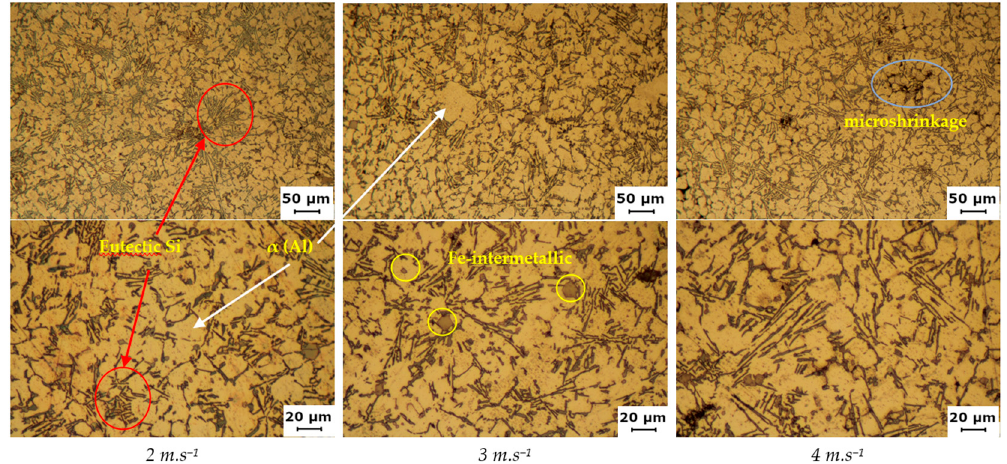
Figure 9. Micrographs of the SB 120 variant tube parts at 200 and 500× magnification.